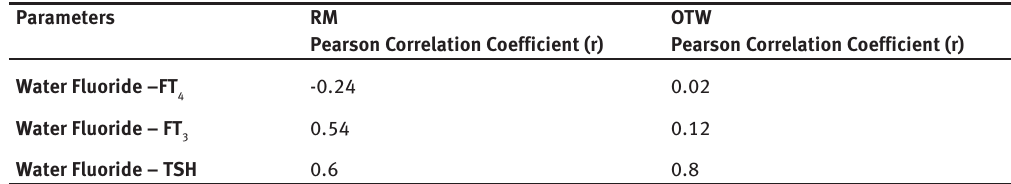
Table 3: Correlation of Serum FT Parameters